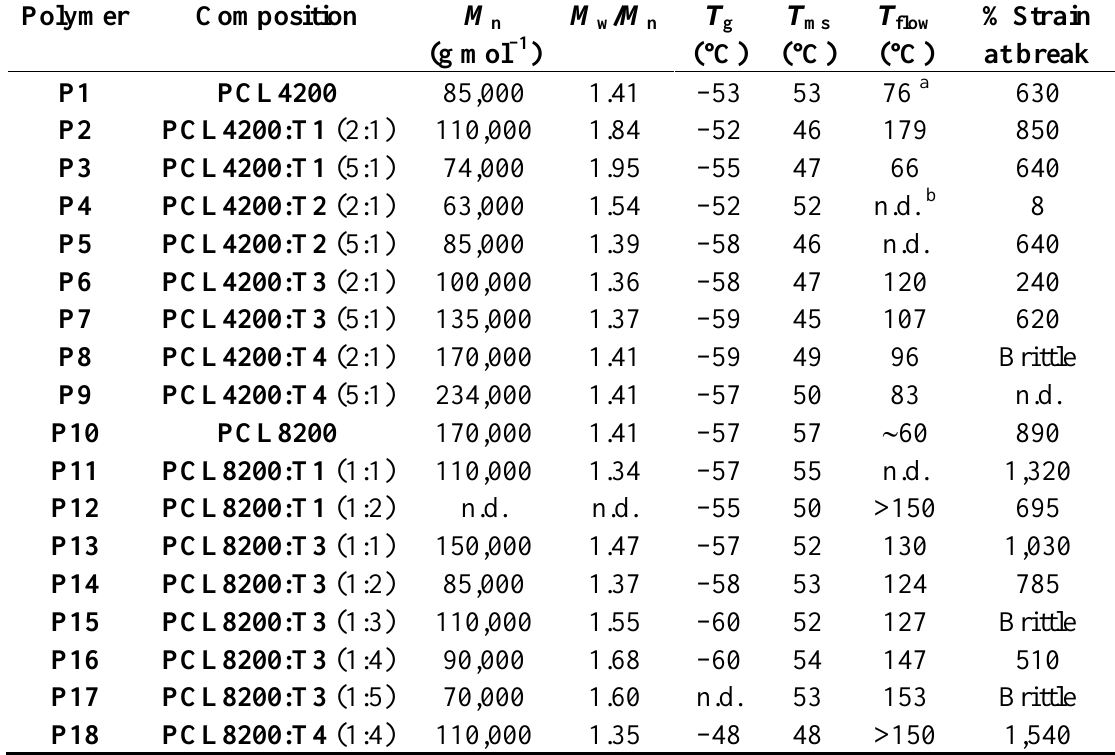
Table 1. Details of polymer composition, molar mass averages, thermal transitions and breaking